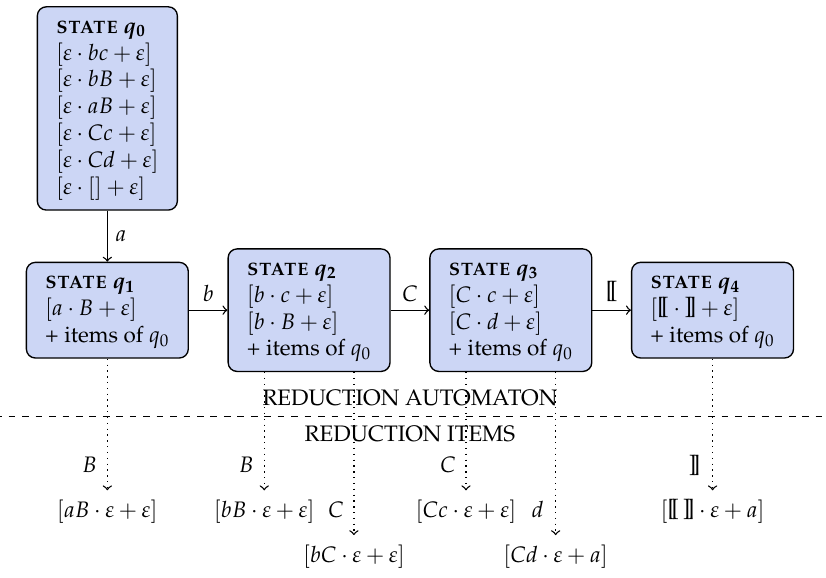
Figure 2. The DFA used by the LLR-system defined in Example 2 (the missing transitions on a , b , C and [[ lead to states 1, 2, 3 and 4, respectively; all other missing transitions lead to state